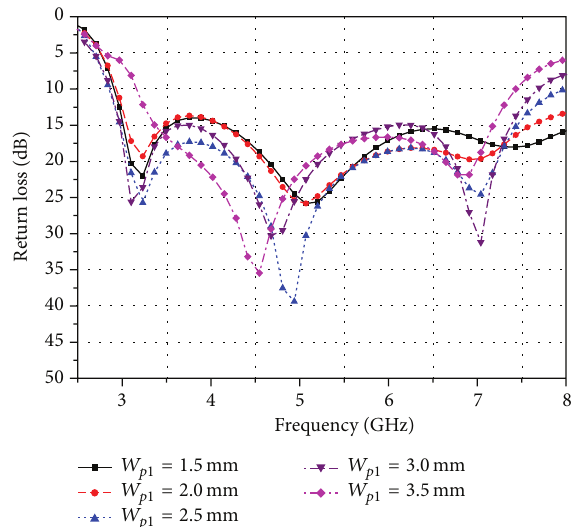
Figure 4: Simulated return loss against frequency for the proposed CPW-fed two-sided T strip wideband microstrip antenna with various values of 𝐿 𝑝3 ; other parameters are the same as listed in